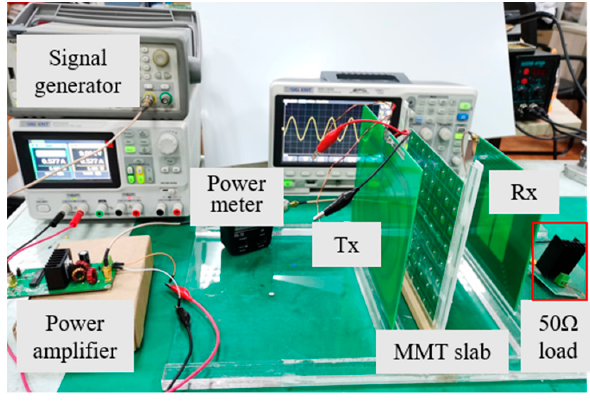
Appl. Sci. 2020 , 10 , x FOR PEER REVIEW Figure 6. The proposed experimental system. Figure 6. The proposed experimental system. Figure 6. The proposed experimental system.